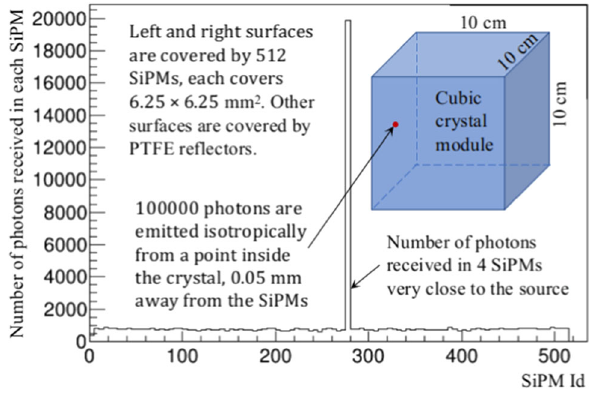
Fig. 14 Number of received photons by individual SiPMs attached to the left and right surfaces of a 10 × 10 × 10 cm 3 crystal in a Geant4-based optical simulation, where 100,000 photons were emitted isotropically from the point shown in the